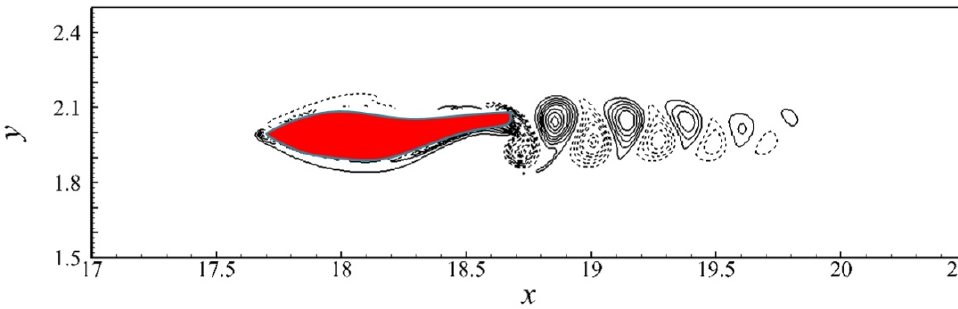
Figure 12. Time history of the forward velocity of the swimming carangiform fish.